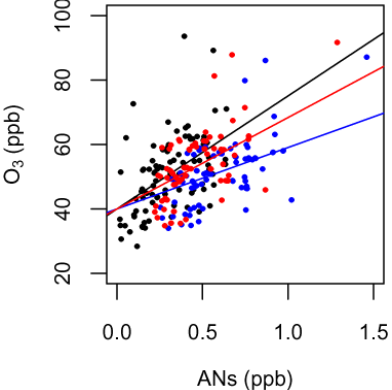
Fig. 4. Observed and simulated relationship between O 3 and P ANs. Black circles are the daytime observations (11–19LST) within 2km of the surface and with isoprene concentration greater than 500 pptv. The blue and red circles are values from the base and IS simulations, respectively, sampled at the location and time of measurements. The black line is the best fit of ob- servations (slope = 35.1, intercept = 40.0, R 2 = 0 . 24, p value = 4 . 05 × 10 − 7 ). The blue line is the best fit for the base simulation (slope = 19.1, intercept fixed at 40.0, squared correlation coefficient of 0.33, p value: < 2.2 × 10 − 16 ) , and the red line is the best fit for the IS simulation (slope = 28.4, intercept fixed at 40.0, squared cor- relation coefficient of 0.33, p value: < 2.2 × 10 − 16 ) .